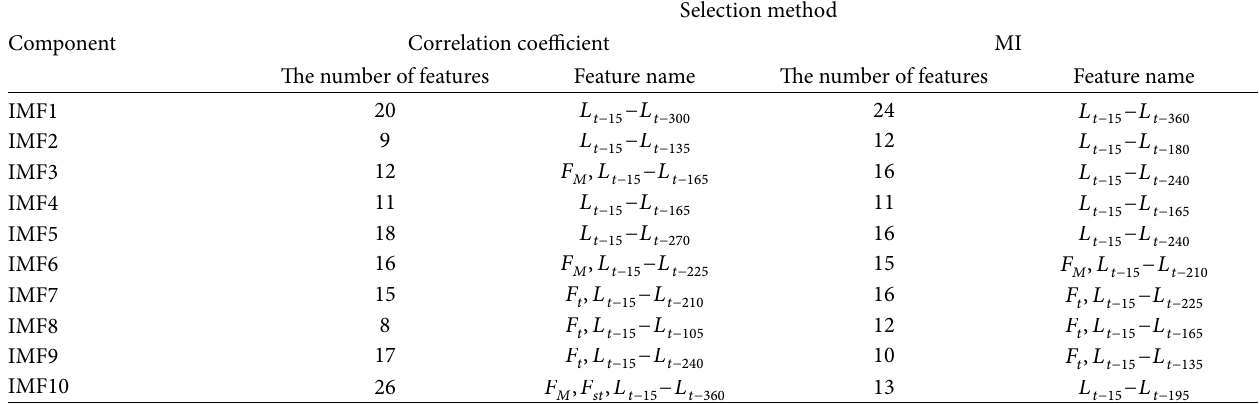
6: The selection results of correlation coefficient and